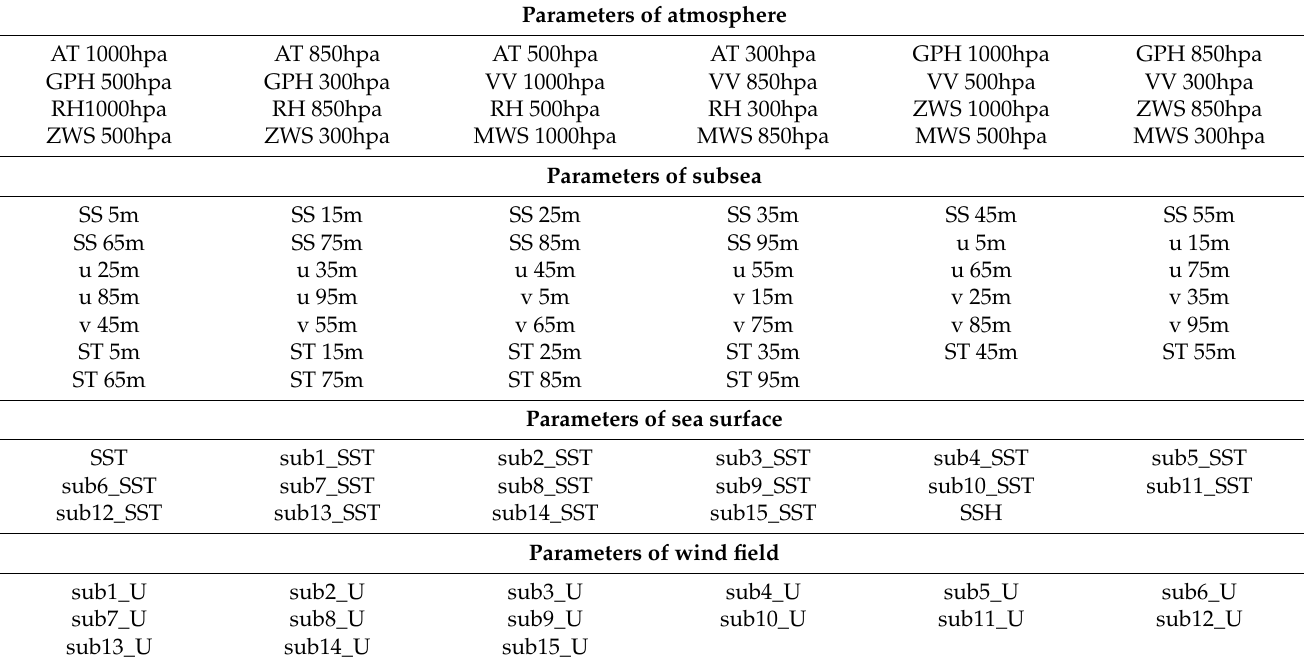
Table 1. 81 Factors used in the